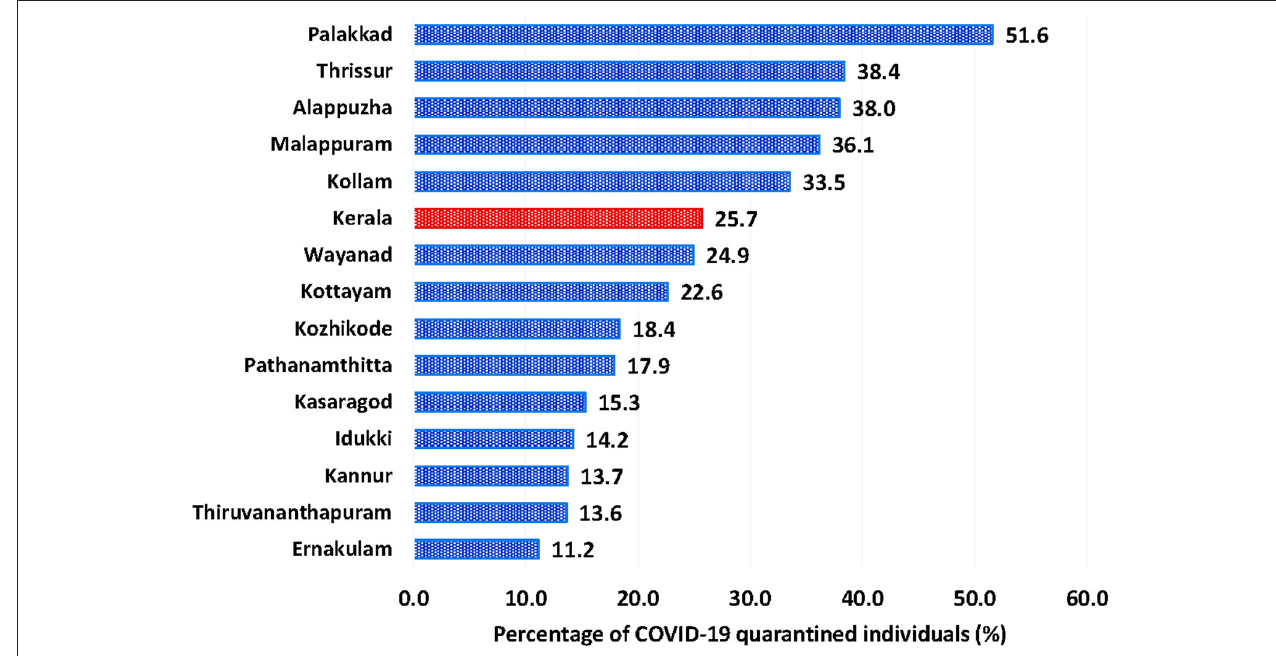
FIGURE 2 | State-wide and district-wise percentage of COVID-19 quarantined individuals enrolled in Amritham from 21May 2020 to 8 July